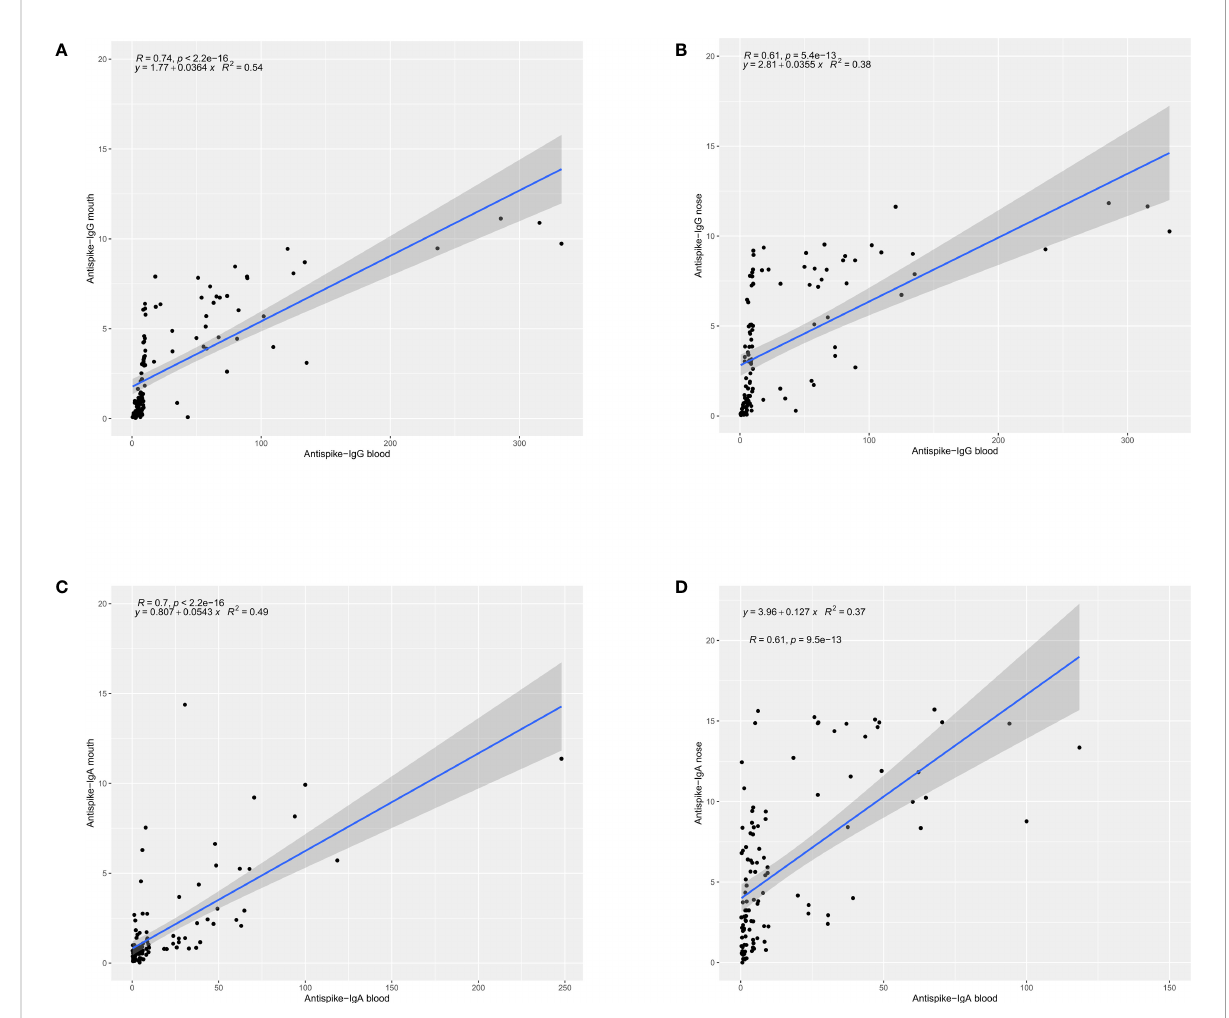
FIGURE 1 Scatterplot graphical display of correlation of the ELISA OD measurements for IgG and IgA Abs in buccal and nasal swabs with the respective measurements in blood. Correlation was determined and reported as Pearson correlation coef fi cient r. (A) Correlation between IgG OD measurement in buccal swabs and blood, (B) Correlation between IgG OD measurement in nasal swabs and blood, (C) Correlation between IgA OD measurement in buccal swabs and blood, (D) Correlation between IgA OD measurement in nasal swabs and